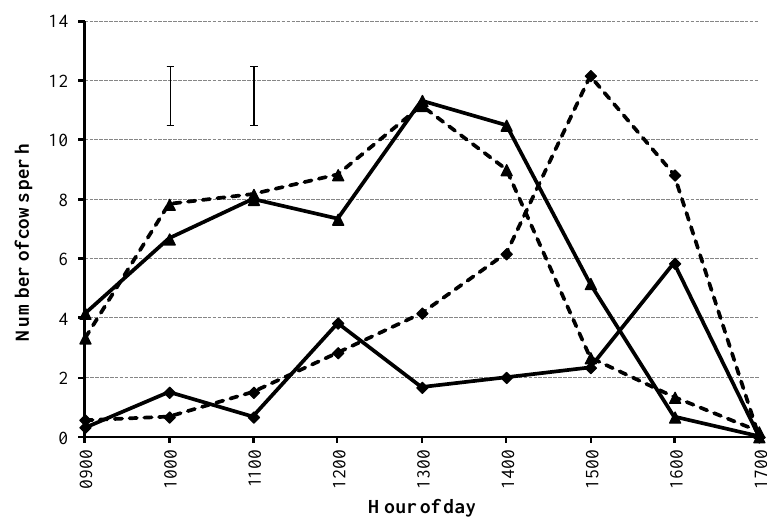
Figure 2. Effect of available grazing time on number of cows per hour entering (triangles) soybean (solid line) or pasture (dashed line) and number of cows per hour exiting (diamonds) soybean (solid line) and pasture (dashed line). Left error bar indicates the average standard error of the difference for cows entering treatment and right error bar indicates the average standard error of the difference for cows exiting